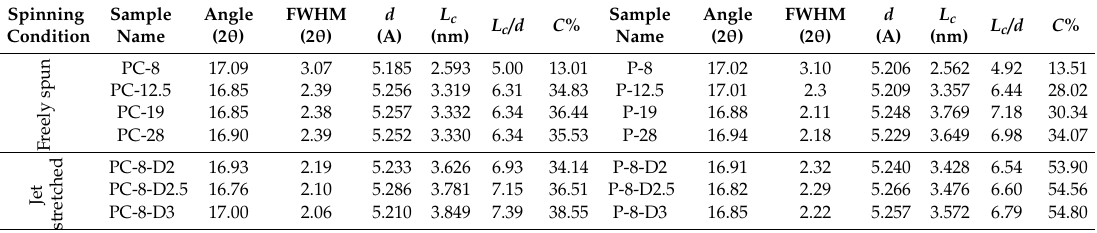
Table 3. Crystalline parameters of PAN and PAN / CNT fibers after peak